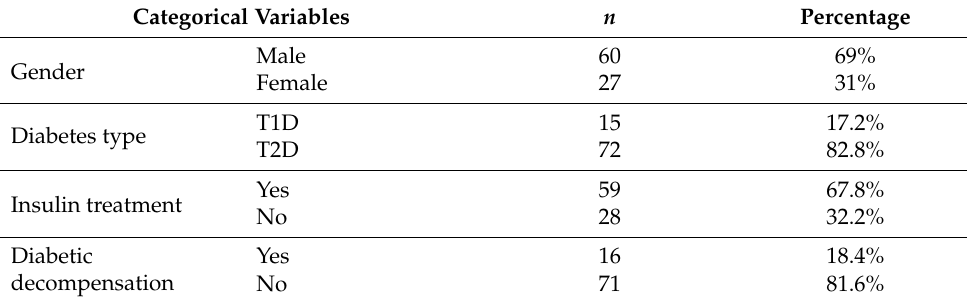
Table 1. Characteristics of the